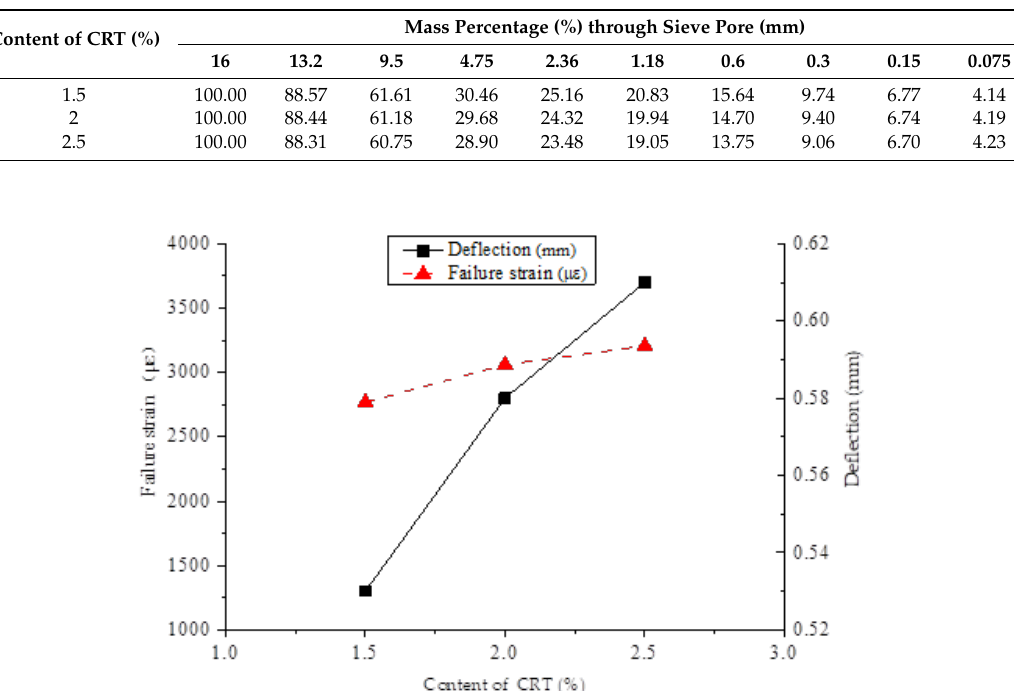
Table 13. Gradations of different substitution ratios.